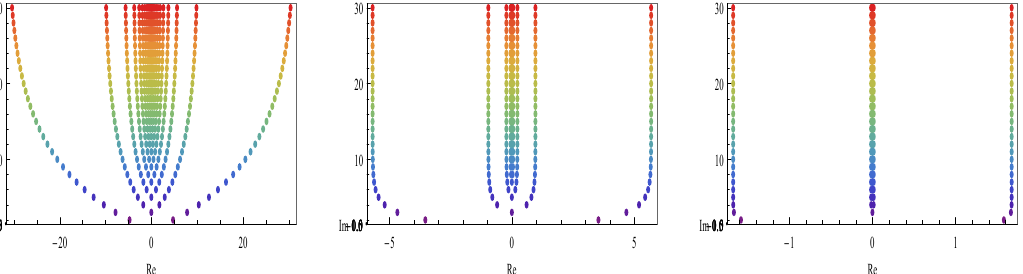
Figure 6. Stacking structure of C n , q ( x ,5 ) for 2 ≤ n ≤ 30, q = 0.9,0.5,0.1.